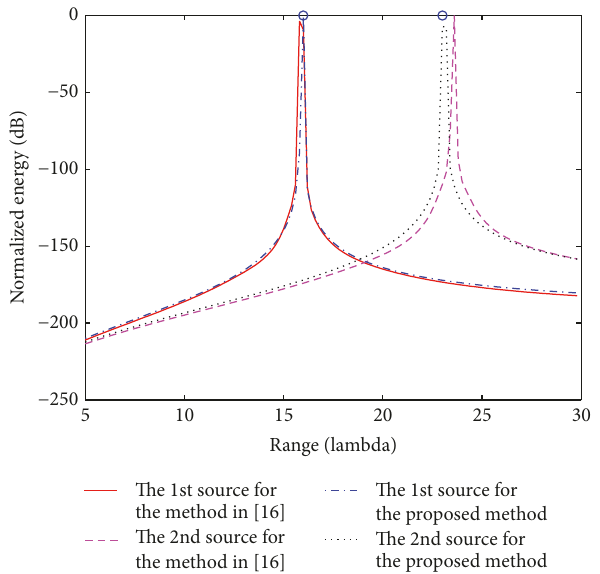
Figure 3: Range spatial spectra for the two methods.